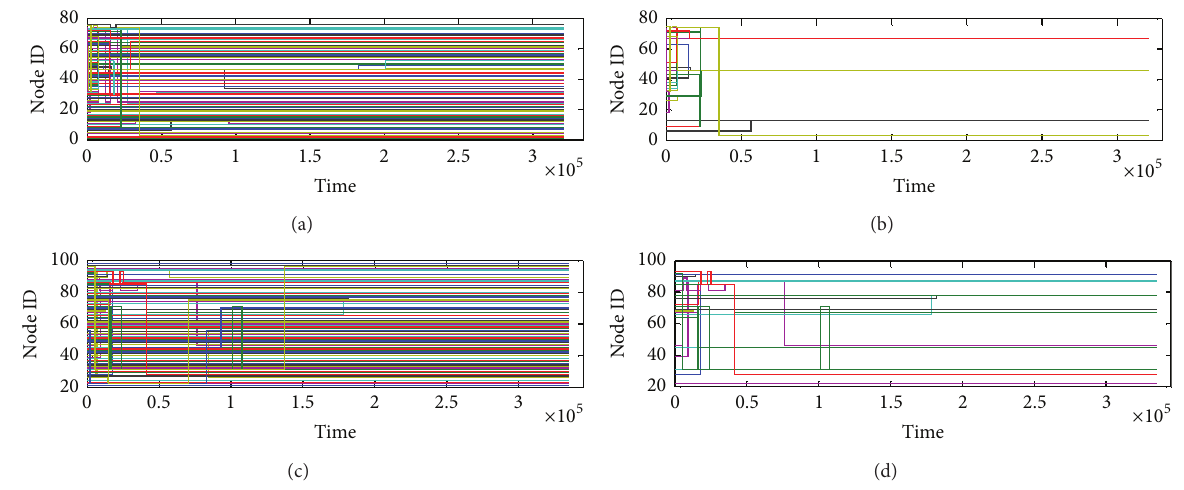
Figure 14: (a) Original community core evolution in SIGCOMM09 with 𝛿 = 0.4 . (b) Refined community core evolution in SIGCOMM09 with 𝛿 = 0.4 . (c) Original community core evolution in INFOCOM06 with 𝛿 = 0.6 . (d) Refined community core evolution in INFOCOM06 with 𝛿 = 0.6